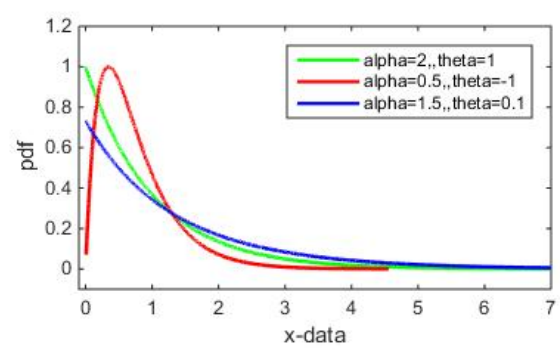
Fig. 1. Plot the pdf of (TE)